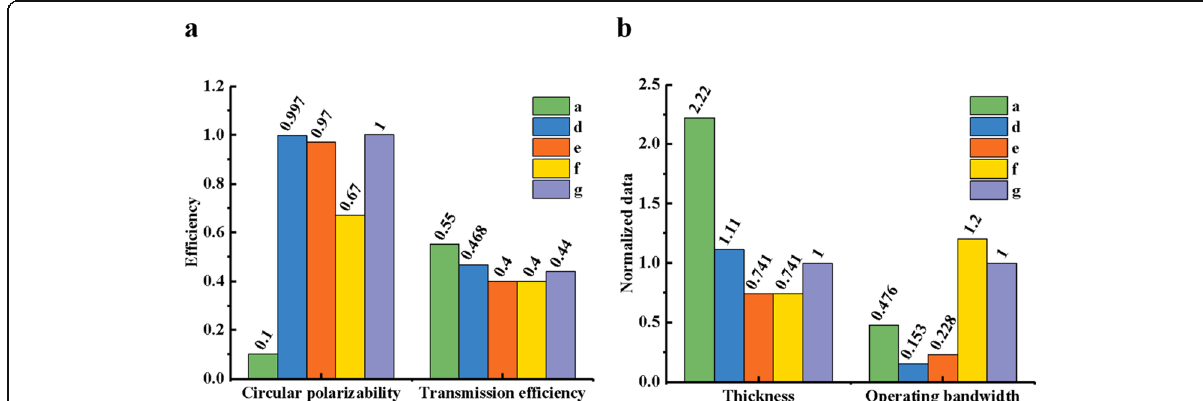
Fig. 4 The comparison of the characteristics of the structures mentioned in Table 1a, d, e, f, and g. a The ellipticity of LTC polarization and the total transmission at 1550 nm. b The normalized metal thickness, and the normalized bandwidth of CTL polarization, based on the proposed structure